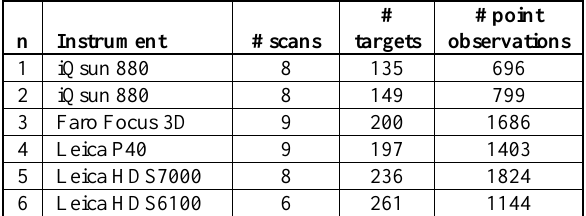
Table 1. TLS self-calibration dataset details.